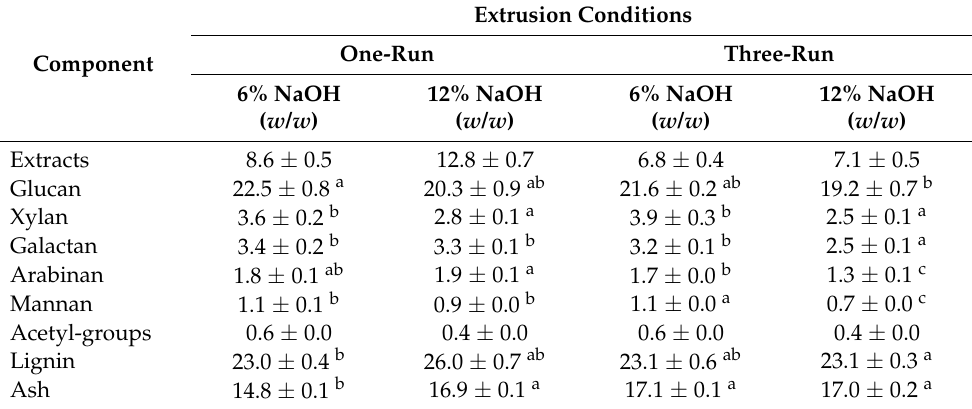
Table 3. Chemical composition of the water-insoluble solid (WIS) fraction collected after extrusion of the vegetal tomato plant waste (VTPW). Data expressed as percentage ( w/w ) on a DW basis. Values followed by different letter in the same row are significantly different at the 95%